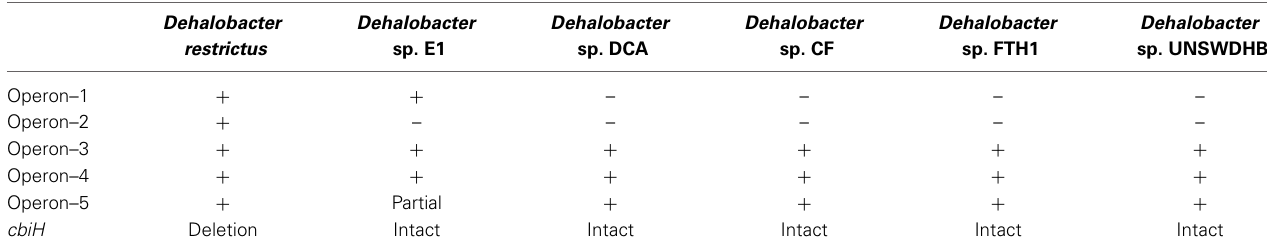
Table 1 | Comparative genomics of corrinoid operons in Dehalobacter